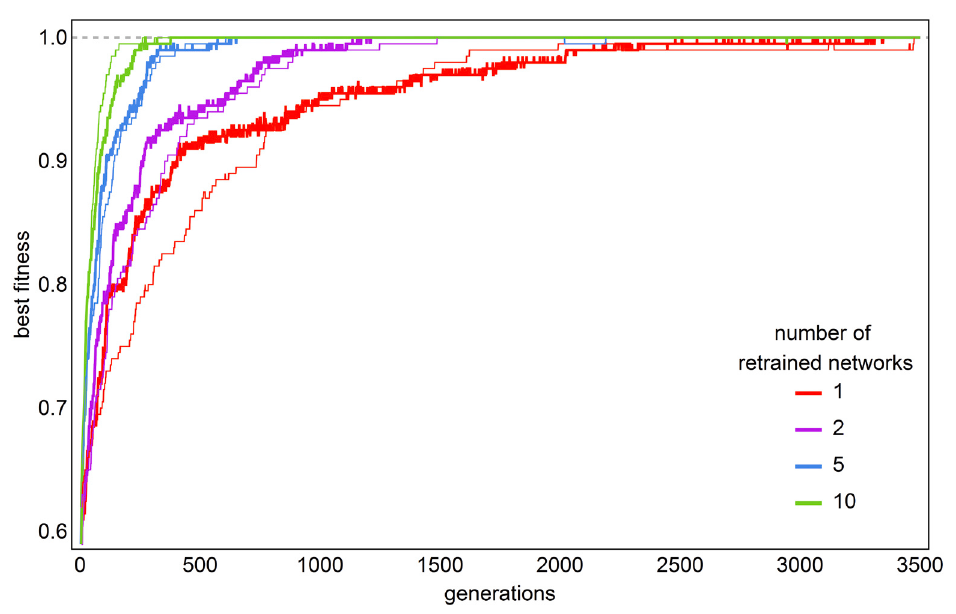
Figure 3. The effect of retraining on the speed of evolution. Lines represent the evolution in four different populations, where a different number of networks were retrained. Each population consisted of 10 networks (see the rest of the parameters under the Methods section). Thin lines: stochastic attractor dynamics; thick lines: simulated attractor dynamics (abstract networks always return the stored attractor prototype that is closest to the actual input, with 0.001 per bit probability noise; capacity to store C